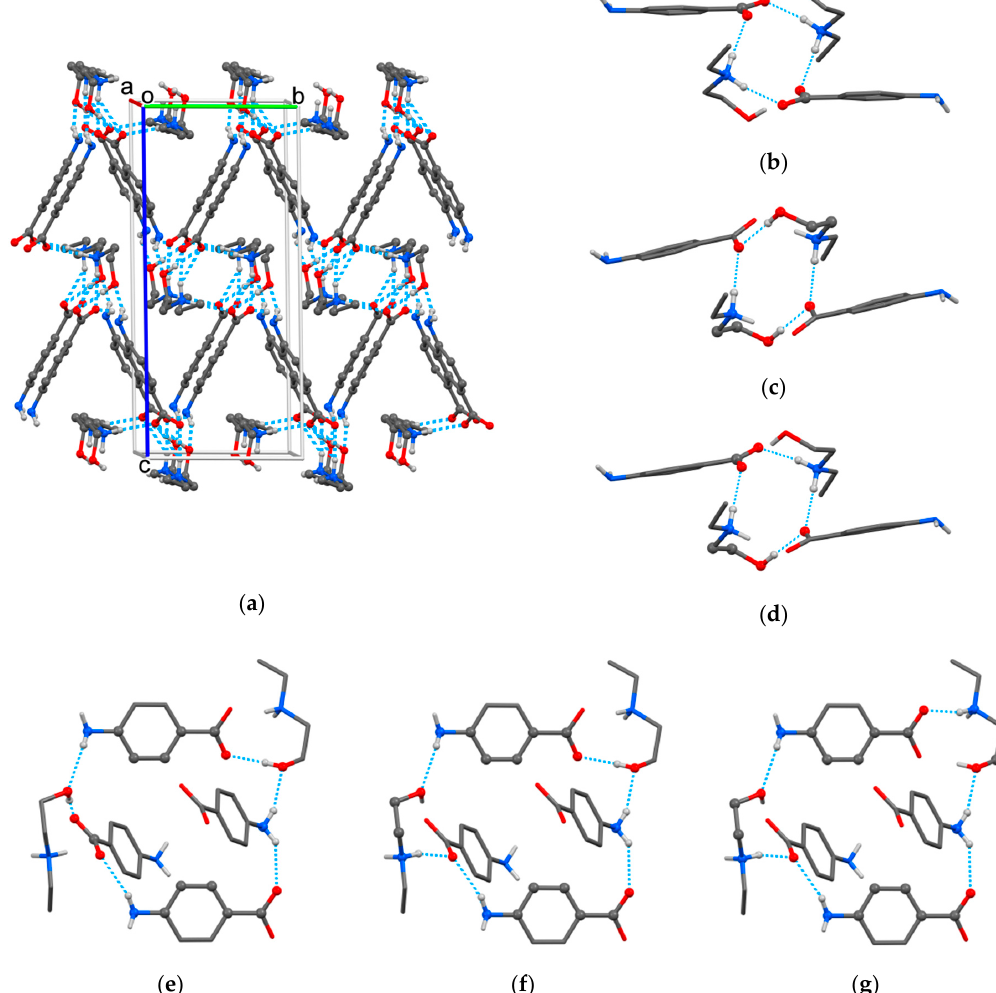
Figure 3. The crystal packing ( a ) and multicomponent heterosynthons found in HDEEA- p ABA crystal: R 44 (12) ( b ), R 24 (14) ( c ), R 34 (13) ( d ), R 66 (26) ( e ), R 56 (27) ( f ) and R 56 (30) ( g ).